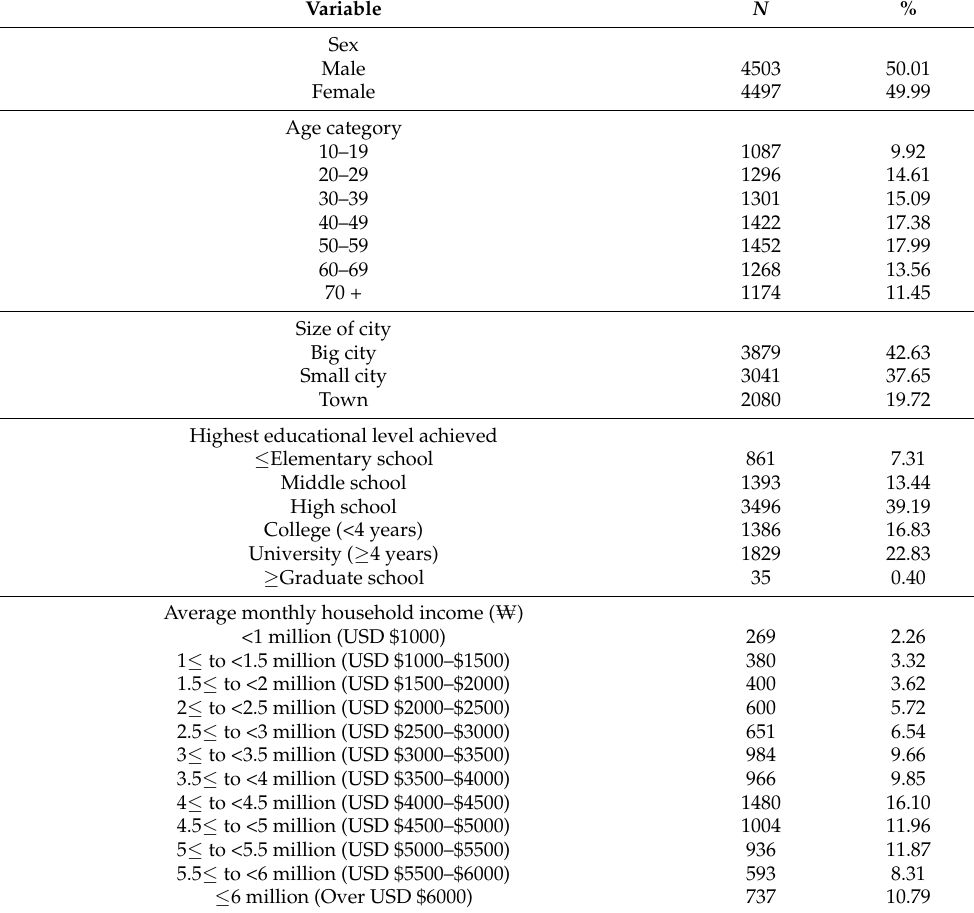
Table 1. Participant characteristics ( n =